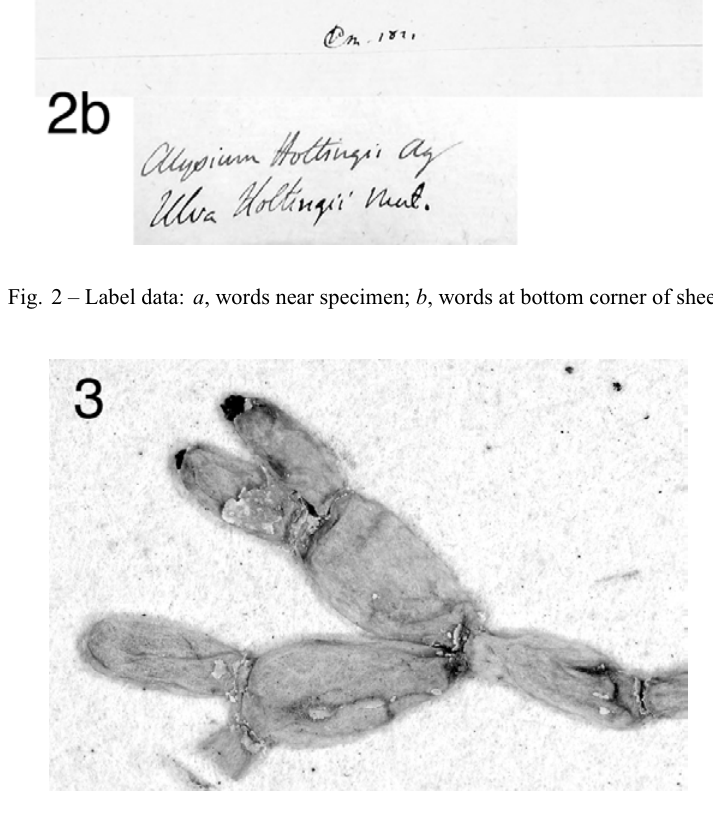
Fig. 3 – Close-up of portion of lectotype